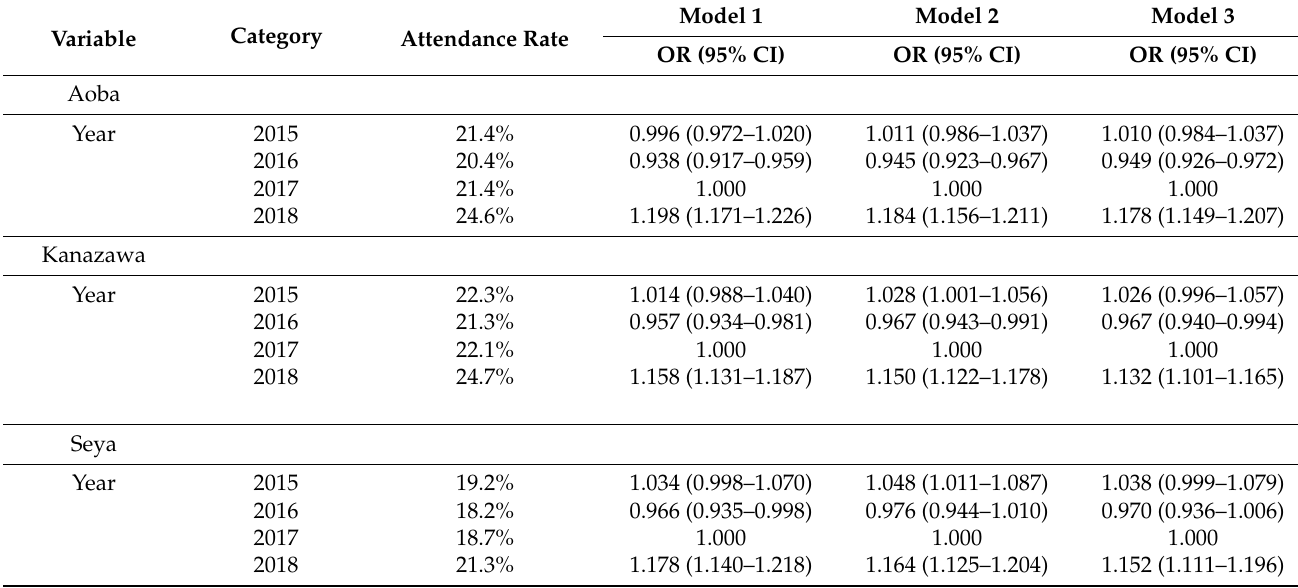
Table 4. Increases in specific health check attendance after the out-of-pocket cost removal intervention in subgroups by residential